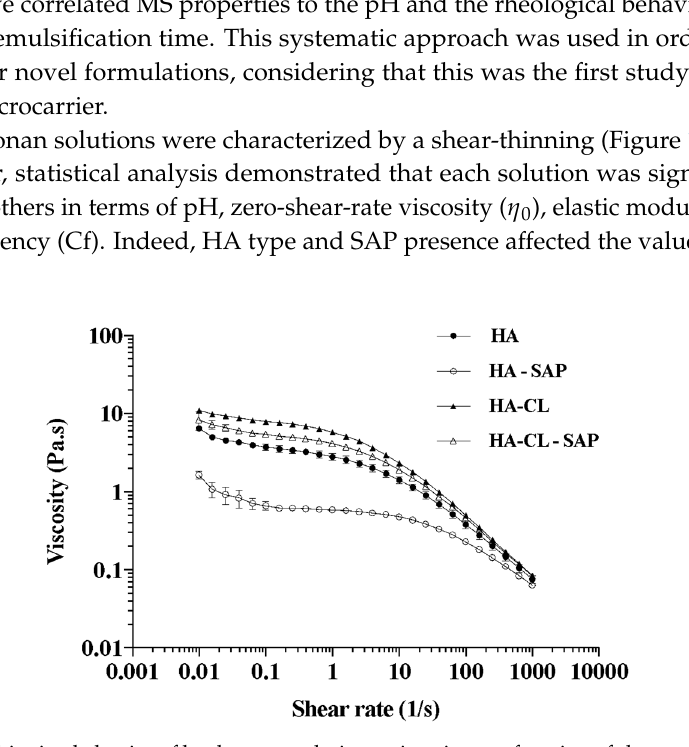
Figure 1. Shear-thinning behavior of hyaluronan solutions: viscosity as a function of shear rate ( n = 3, ± SD). Table 1. Main properties of HA solutions: pH, η 0 , G ′ 1Hz , C f ( n = 3, ± SD).